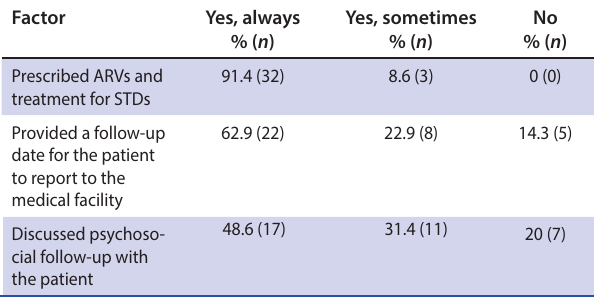
Table 5: Treatment administered ( n = 35) Factor